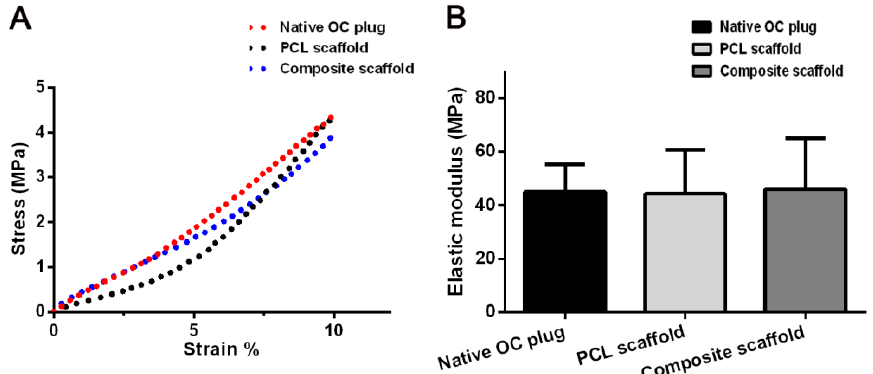
Figure 3. Compressive strength ( A ) and elastic moduli ( B ) of PCL scaffold, composite scaffold, and native OC plug. Results are expressed as mean ± SD ( n = 3).